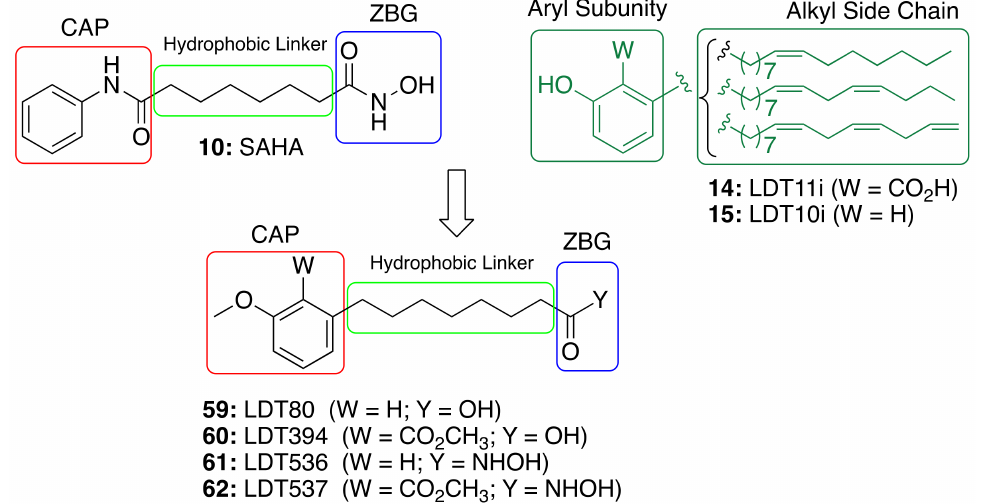
Figure 9. Design of CNSL-derived HDAC inhibitors LDT536 ( 61 ) and LDT537 ( 62 ) from the octanoic acids LDT80 ( 59 ) and LDT394 ( 60